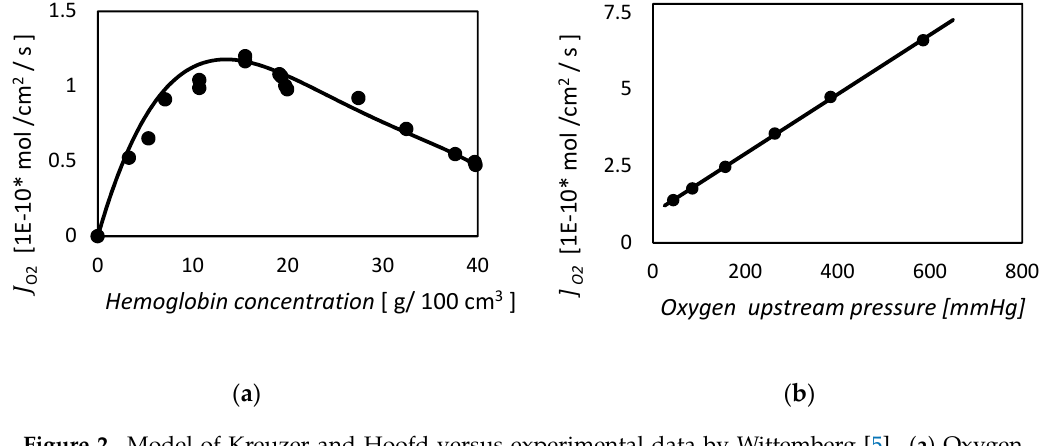
Figure 2. Model of Kreuzer and Hoofd versus experimental data by Wittemberg [5]. ( a ) Oxygen facilitated flux in function of hemoglobin concentration; ( b ) oxygen facilitated flux in function of the oxygen pressure at the feed side. In both figures the points are the experimental data, the line reports the model prediction. The flux reported is the reactive component of the total flux.